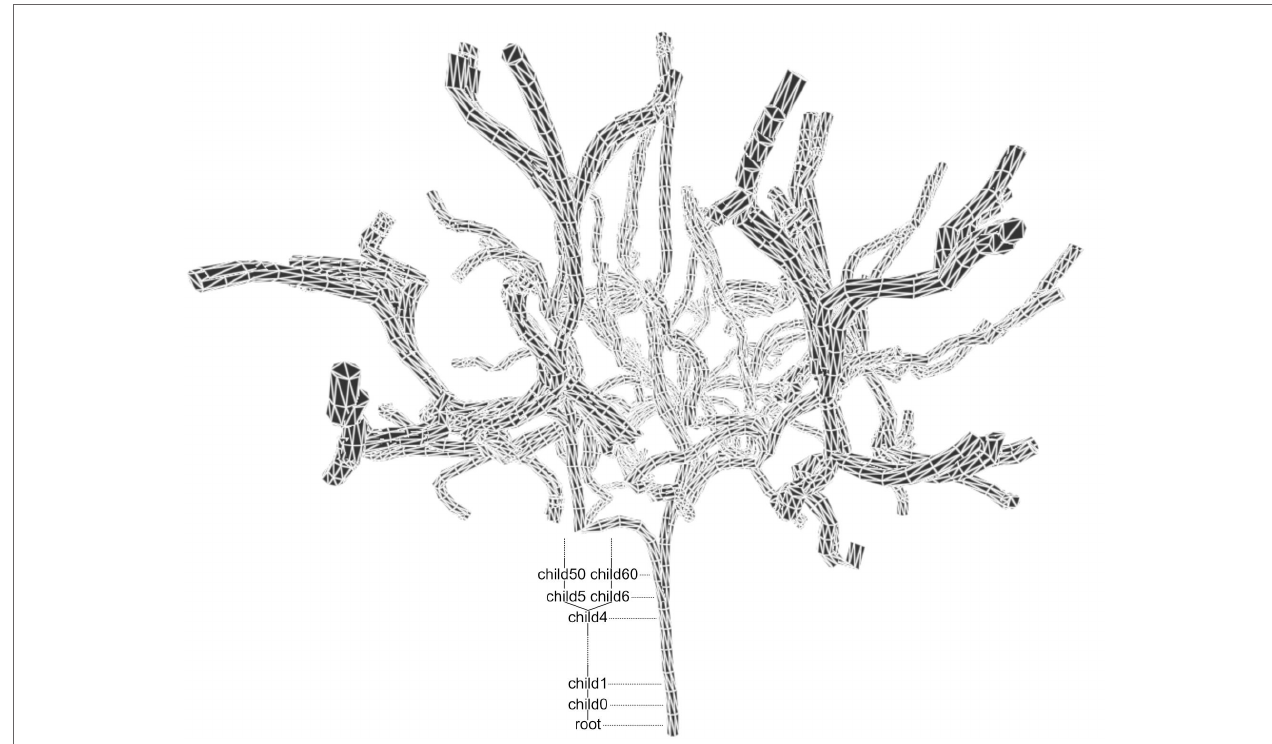
0 01 = = , =  → . { { }} α and C implementing upwards 4